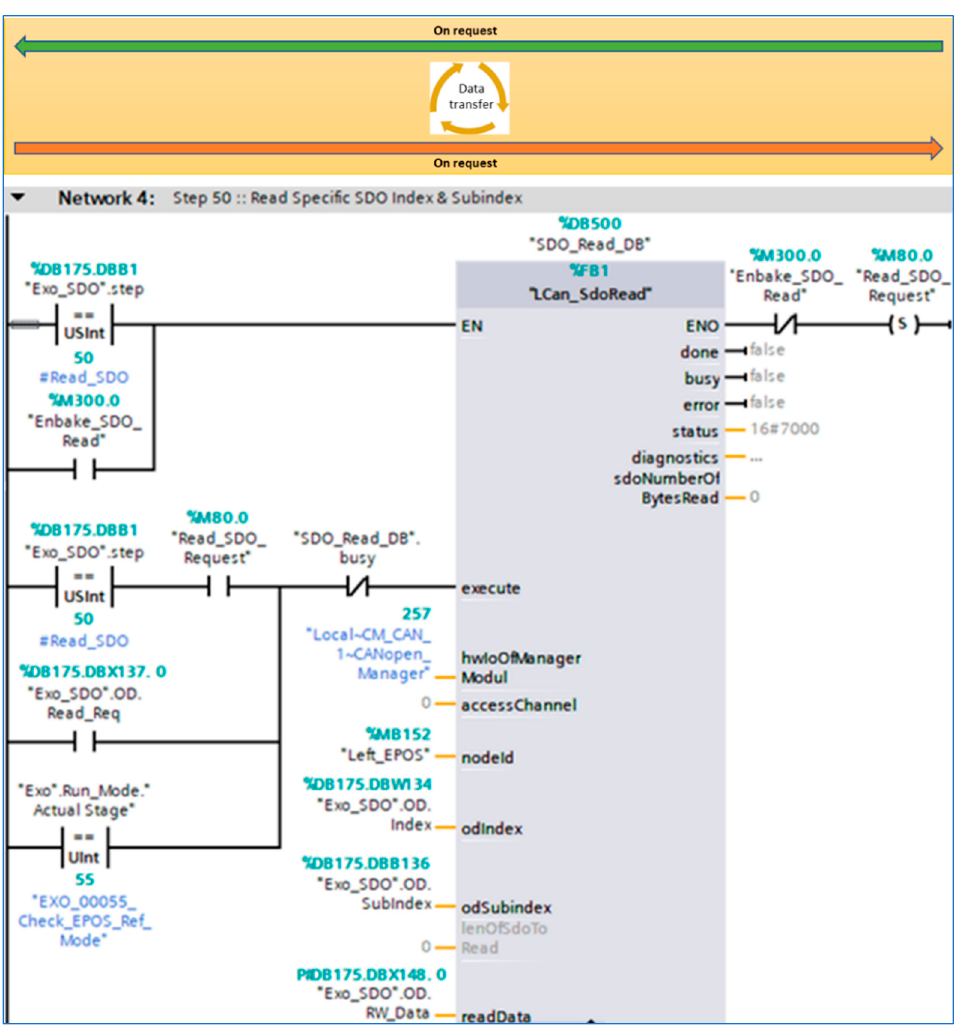
Figure 10. Control logic for reading from every EPOS4 controller.